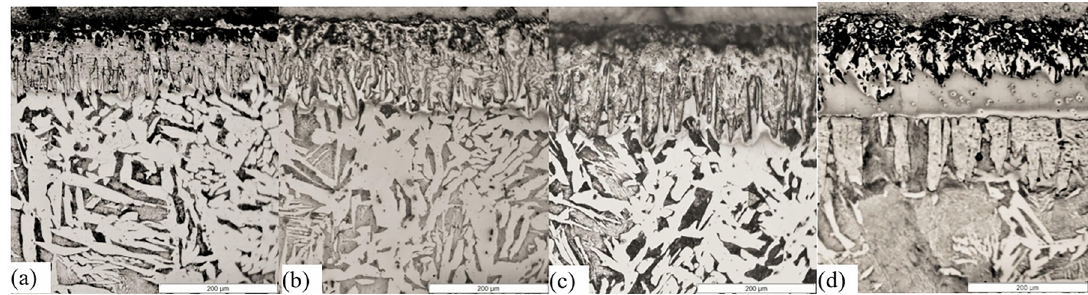
Figure 3. (a) cross-section optical micrograph of AISI 1020 at 1000º C for 2h, (b) cross-section optical micrograph of AISI 1020 at 1100º C for 2h, (c) cross-section optical micrograph of AISI 1020 at 1000º C for 10h, (d) cross-section optical micrograph of AISI 1020 at 1100º C for 10h.